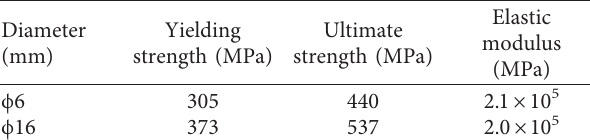
Table 3: Mechanical properties of the steel bars.